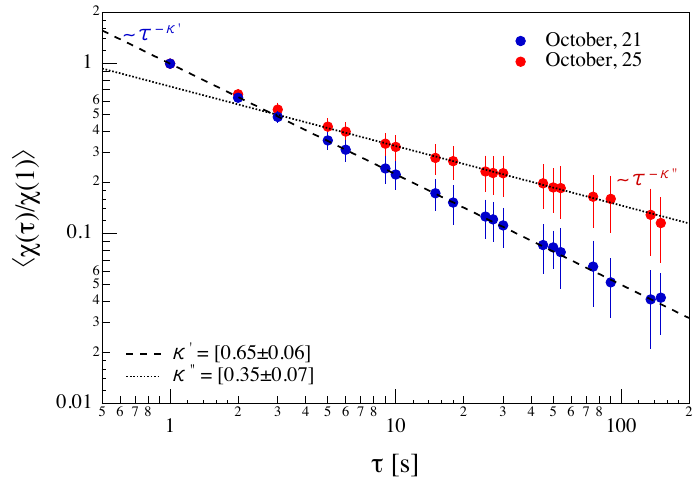
Figure 7. The mean normalized partition function, (cid:104) χ ( τ ) / χ ( 1 ) (cid:105) , for the two selected days char- acterized by different geomagnetic disturbance levels. The dashed black line is a power-law (cid:104) χ ( τ ) / χ ( 1 ) (cid:105) = τ − κ (cid:48) . The dotted line is a power-law fit, (cid:104) χ ( τ ) / χ ( 1 ) (cid:105) ∝ τ − κ (cid:48)(cid:48) , of the average partition function for 25 October 2016 in the range τ ∈ [ 5,100 ]